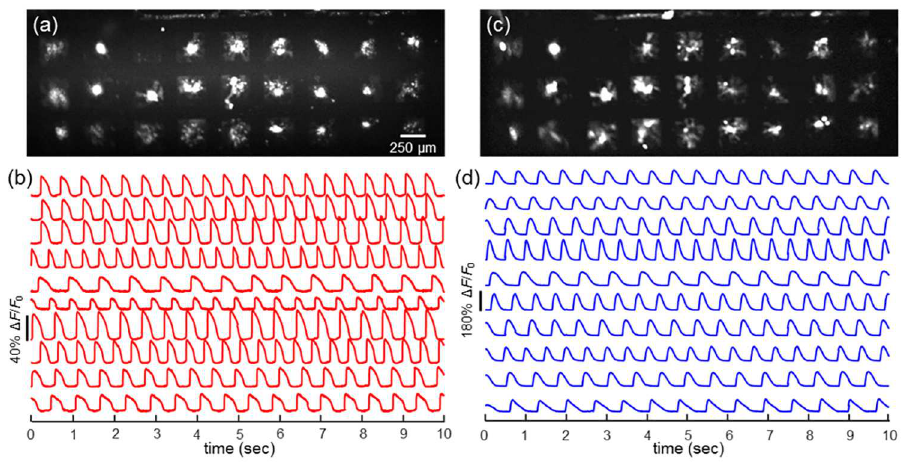
Fig 2. Optical electrophysiology recordings. (a) Fluorescence image of QuasAr2 expressed in 250 μ m islands, all of which were monitored simultaneously at a 500 Hz frame rate. b) Fluorescence recordings of QuasAr2, indicating voltage, from islands in (a). The individual islands showed heterogeneity in spontaneous beat rate and action-potential waveform. c) Fluorescence of GCaMP6F expressed in the same islands as in (a). d) Fluorescence recordings of GCaMP6F, indicating Ca 2+ , from islands in (c). Data in (b) and (d) has been corrected for slow photobleaching, but not otherwise